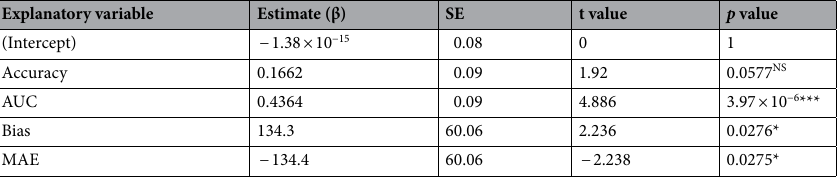
Table 2. Results of multiple linear regression; F = 10.07; df (4, 99); R 2 = 0.2604; p = 7.051 × 10 −7 . Symbols indicate: ***Significant at 0.001; *Significant at 0.05. NS not